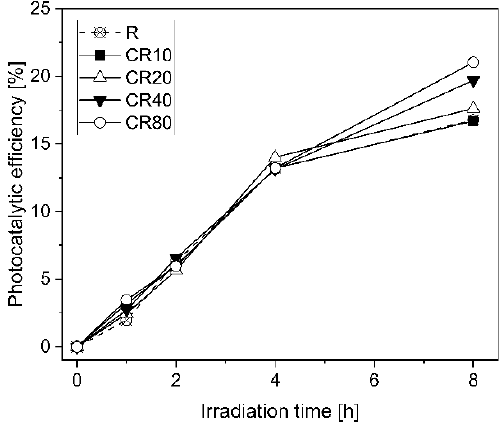
Figure 5. The influence of TiO 2 coating rates on the photocatalytic efficiency.